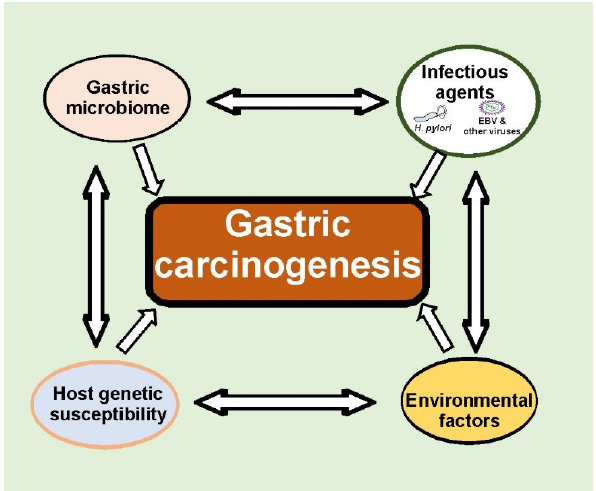
Figure 3. Multifaceted interactions between infectious agents, gastric microbiomes, and host genetic and environmental factors define tumorigenic processes in the stomach. Many aspects of these interactions remain currently